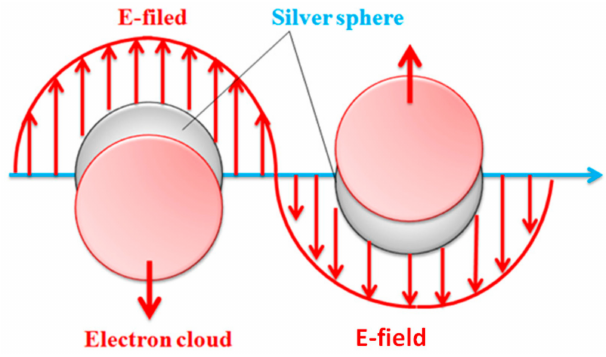
Figure 9. Nanoparticles in plasmon